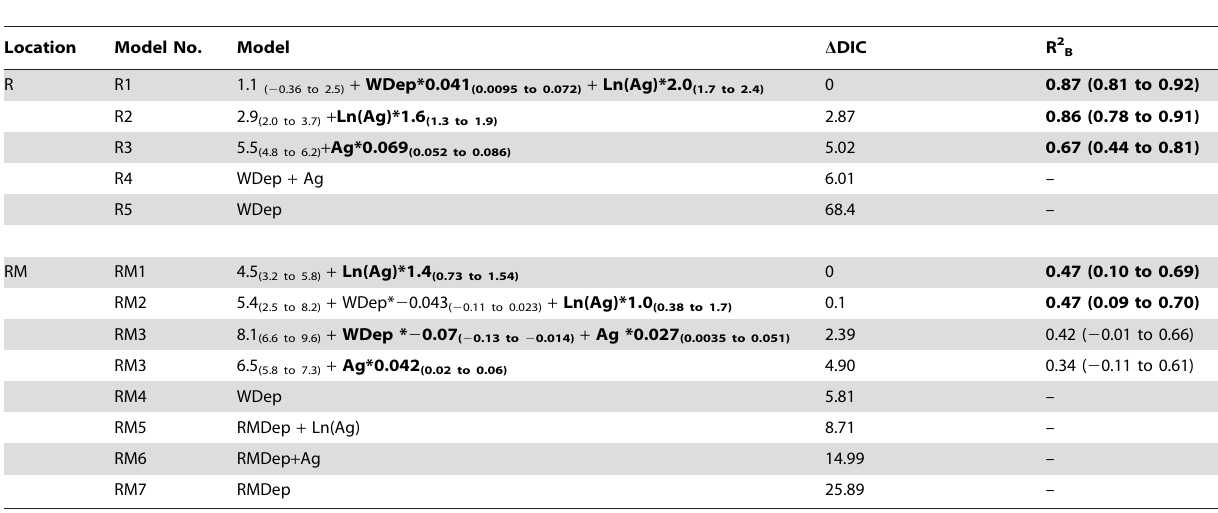
Table 2. Results of model selection for relationship between watershed properties and d 15 N in consumers and seston.